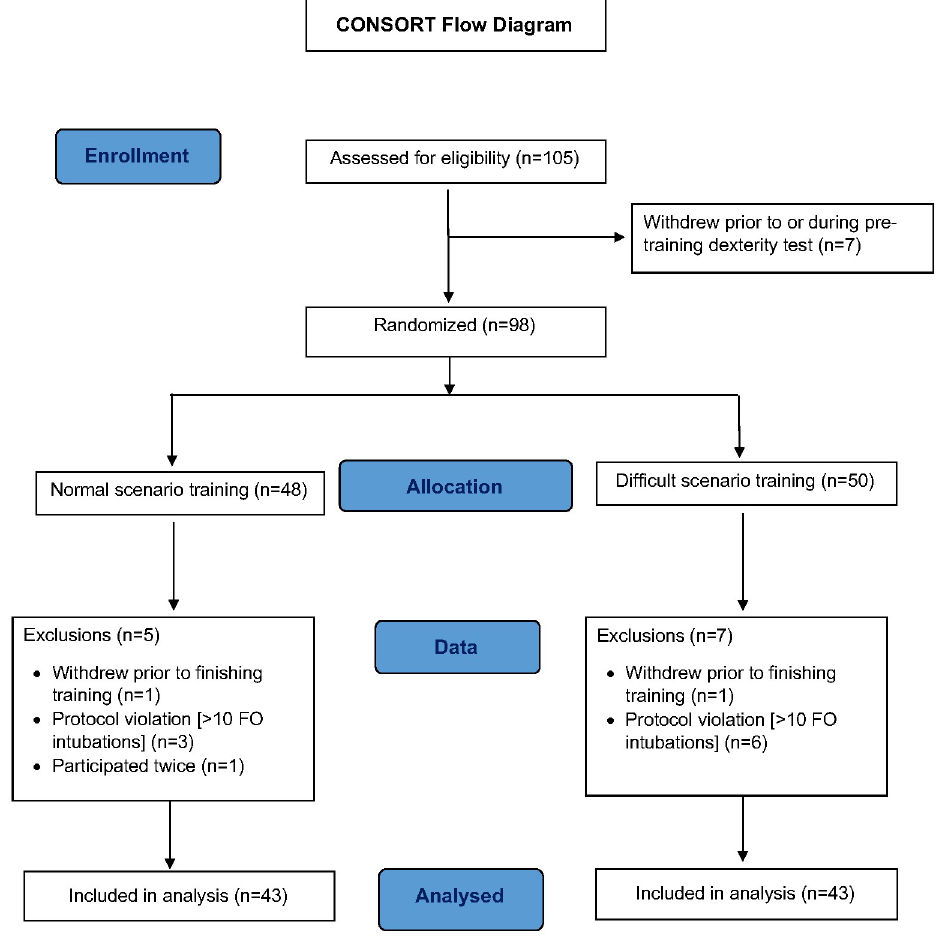
Fig 1. CONSORT flow